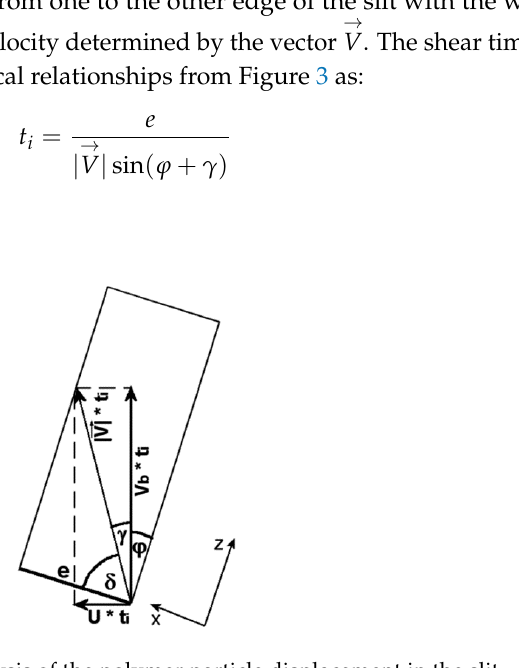
Figure 4. The vector analysis of the polymer particle displacement in the slit.